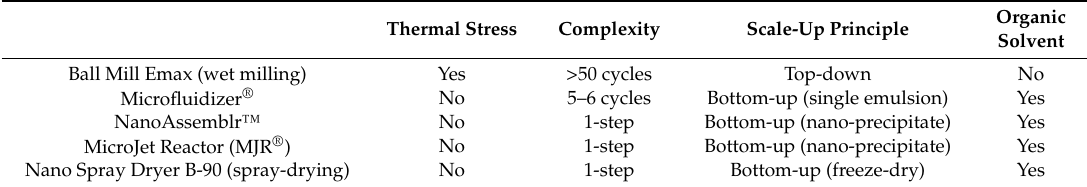
Table 2. Critical parameters for scale-up or GMP manufacturing of nanomedicine technology for